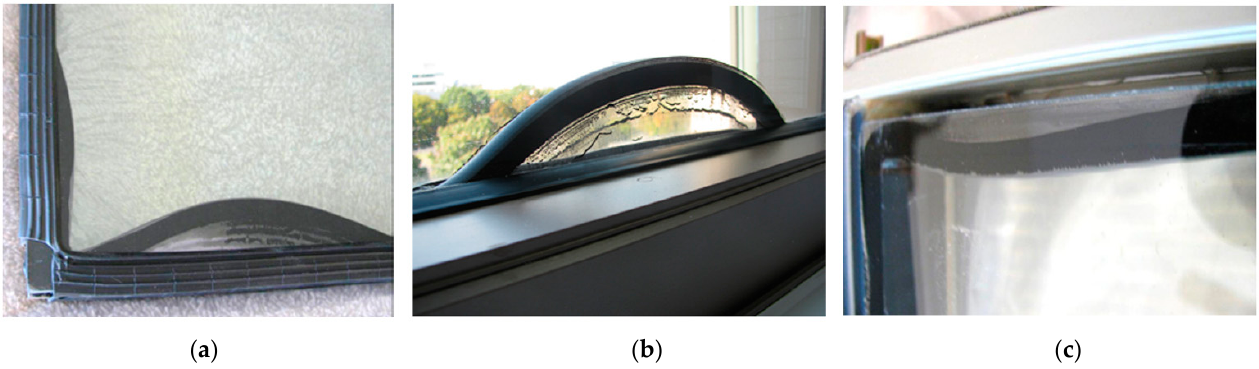
Figure 1. Examples of the IGUs with a PIB dual-seal showing considerable displacement of the IGU spacer seal assembly (see report by Watson et al. [11]). (reproduced, with permission from [11], copyright ASTM International, 100 Barr Harbor Drive, West Conshohocken, PA